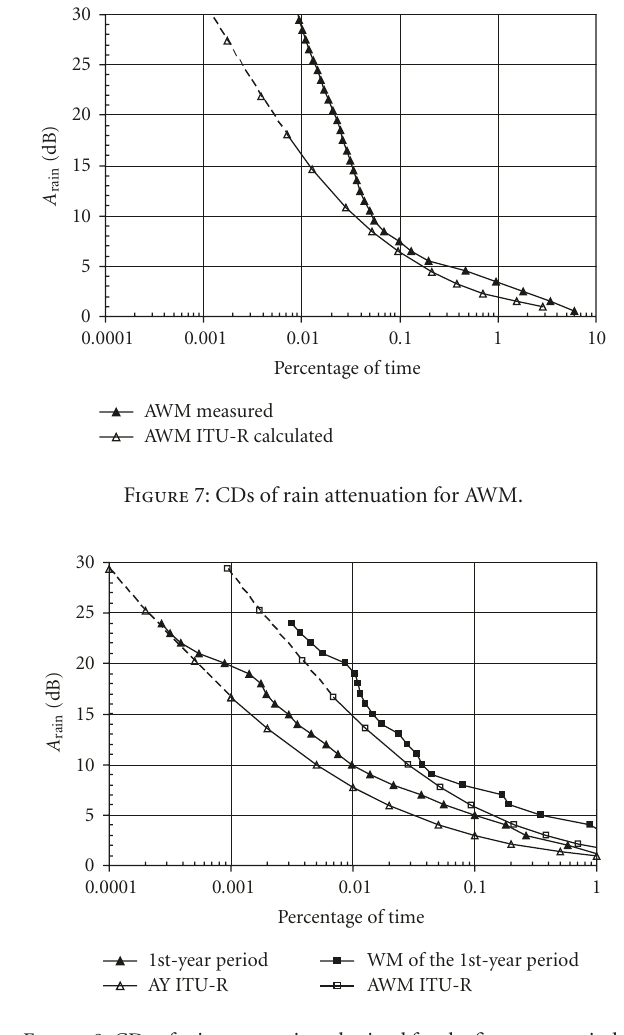
Figure 8: CDs of rain attenuation obtained for the first-year